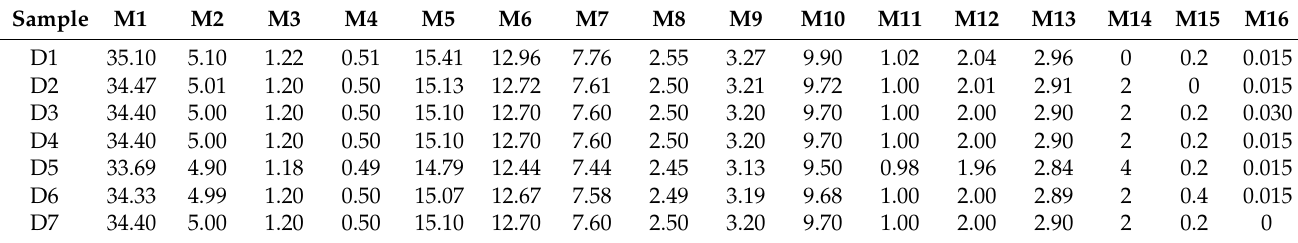
Table 7. Test mix proportions of tunnel fireproof coatings (TFC)